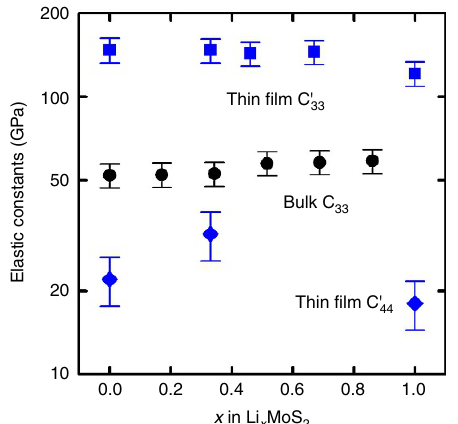
Figure 6 | Effective elastic constant of thin-film Li x MoS 2 with different (square) decreases from 147GPa ( x ¼ 0) to degrees of lithiation. C 0 33 (diamond) increases from 22GPa ( x ¼ 0) to 32GPa 121GPa ( x ¼ 1). C 0 44 ( x ¼ 0.34) and then decreases to 18GPa ( x ¼ 1). As comparison, the C 33 of bulk Li x MoS 2 samples (circle) are also plotted. C 33 gradually changes from 52GPa ( x ¼ 0) to 58GPa ( x ¼ 0.86) with a transition point at x E 0.34. The error bars are calculated by taking into account the experimental errors and the systematic errors that propagate from uncertainties in the Al film thickness, Li x MoS 2 film density and the input elastic constants.